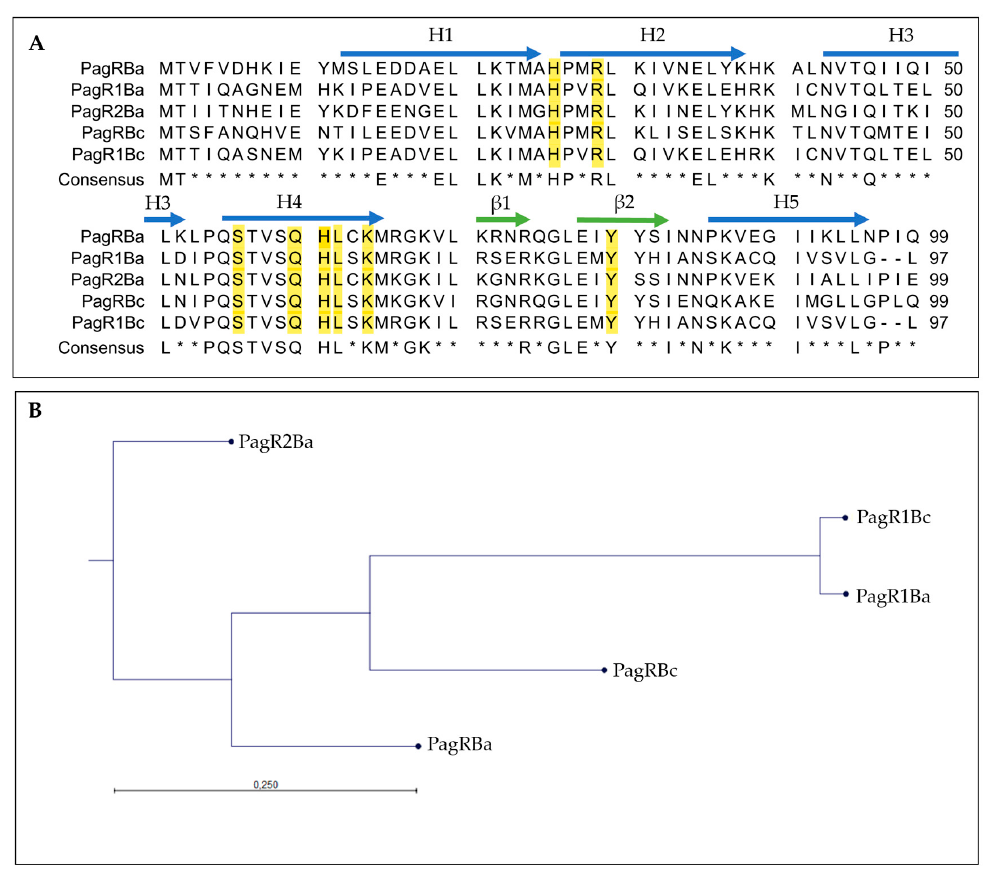
Figure 1. Amino acid sequence analysis of B. anthracis PagR (PagRBa) and its homologues on plasmids pXO1, pXO2 and pCER270. ( A ): Multiple sequence alignment of PagR homologues in emetic B. cereus and B. anthracis . The protein sequences of PagRBc (YP_002335935.1) from the emetic reference strain B. cereus F4810/72 and PagR1Bc (ACJ82764.1) were aligned to the two PagR protein sequences of B. anthracis Sterne encoded on pXO1 (PagR and PagR1) and the PagR homologue of B. anthracis Pasteur PagR2 encoded on pXO2 (for details of genome location, see Supplementary Figure S2). Sequences were retrieved from NCBI GenBank as follows: PagRBa (WP_000215715.1), PagR1Ba (AAD32441.1) and PagR2Ba (AJH31838.1). The consensus sequence is shown as identical amino acid residues in all PagRs in capital letters. Residues essential for DNA binding and physiological protein structure are highlighted in yellow [33]. Alpha helices (H1 to H5) are labelled with blue arrows and β -Sheets ( β 1 and β 2) are labelled with green arrows. Asterisks * indicates amino acids not conserved in all sequences. ( B ): Protein similarity tree of the different PagR homologues based on the amino acid sequences of homologues from B. cereus (abbreviation: Bc) and B. anthracis (abbreviation: Ba) was calculated. The tree was constructed with the neighbor-joining method employing CLC Workbench Qiagen software. The Jukes – Cantor model was used for protein distance measurements.